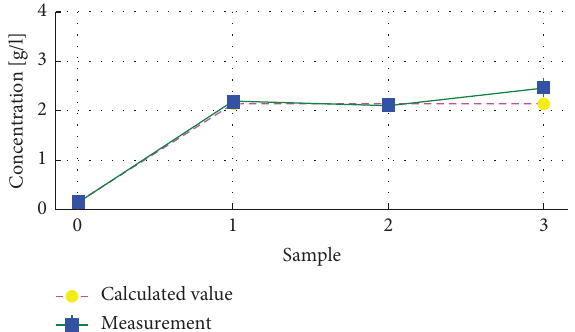
Figure 3: An initial test to determine the efect of sodium acetate on the concentration of acetic acid in